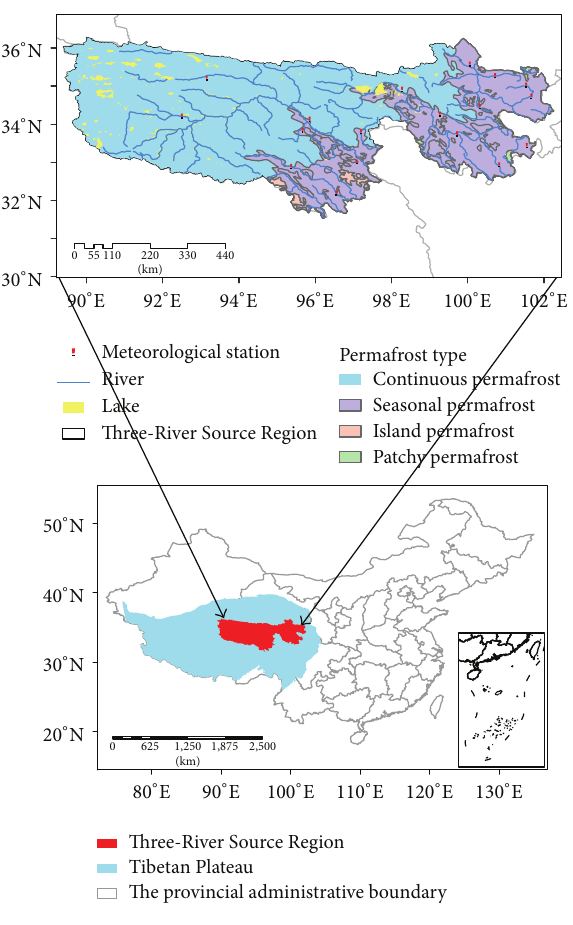
Figure 1: Location of the study